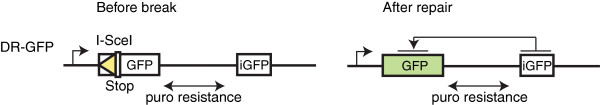
HR Assay. The 5’ GFP is inactivated by several in frame stop codons and contains an I-SceI site. A downstream truncated GFP, lacking the I-SceI sites and stops, serves as a template. Accurate repair via HR results in GFP expression.